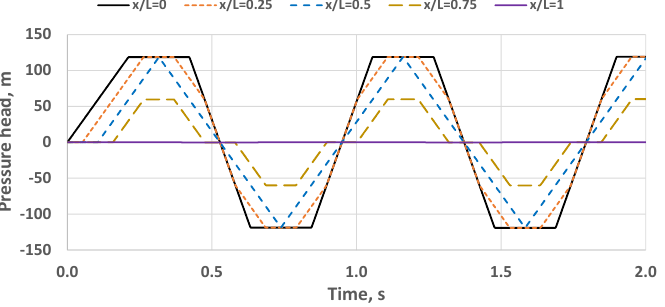
Figure 10. Influence of wave superpositions on pressure histories. (Pressures relative to the reservoir pressure.)